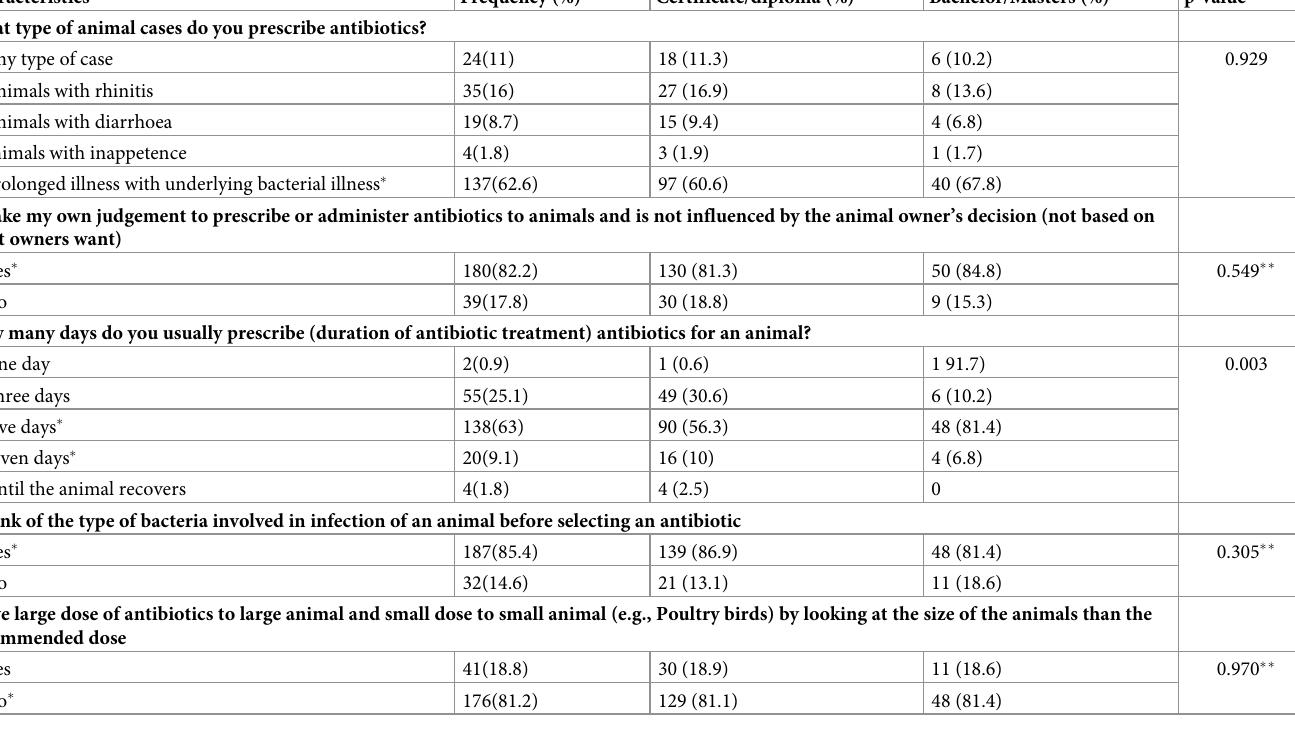
Table 3. Practices on antibiotic prescription among the veterinarians and para-veterinarians.